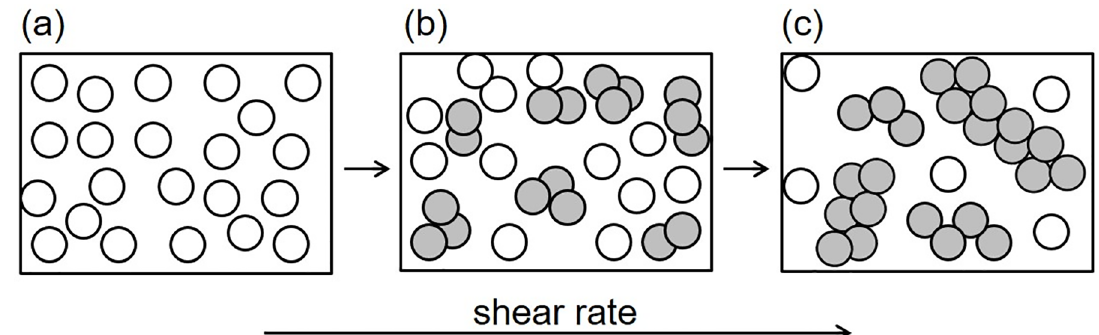
Figure 1. Scheme illustrating hydroclusters formation. Adapted from Liu et al. 7